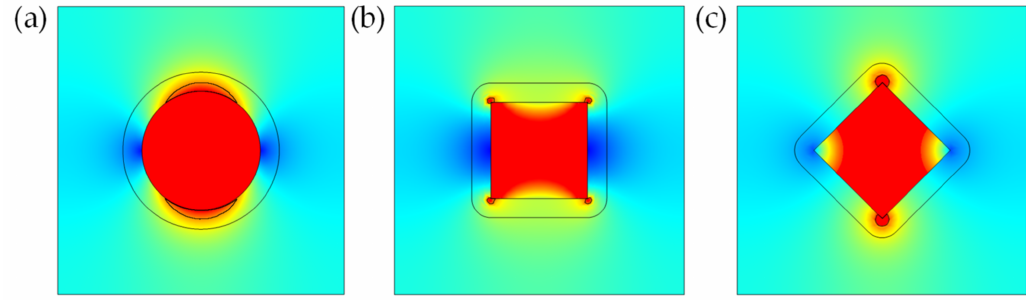
Figure 13. Cloud iamge of conductive heat flux after ImageJ processing. ( a ) Filler particle is small sphere; ( b ) Filler particle is horizontally placed cube; ( c ) Filler particle cube is rotated 45 ◦ .